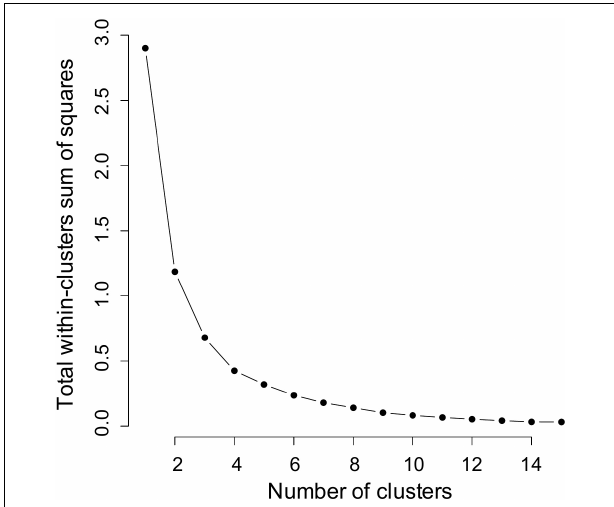
FIGURE 9 | Scree plot (within-clusters sum of squares) of the hierarchical clustering analysis.